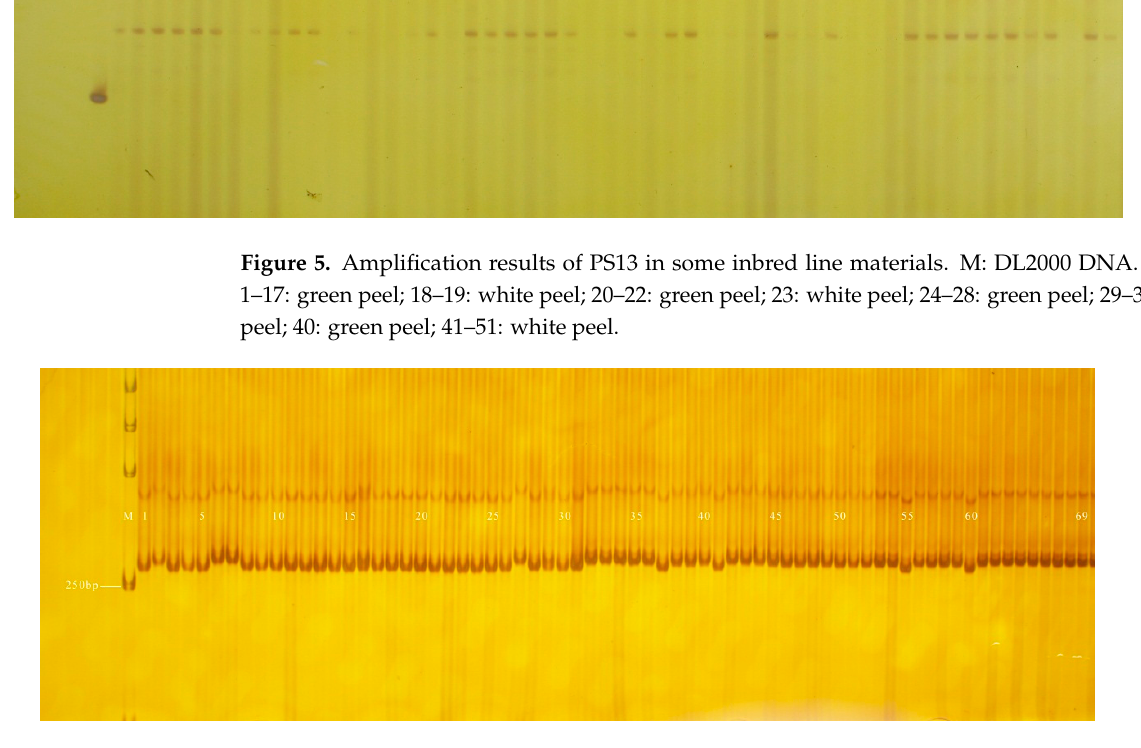
Figure 6. Amplification results of PS28 in some inbred line materials. M: DL2000 DNA Marker; 1–